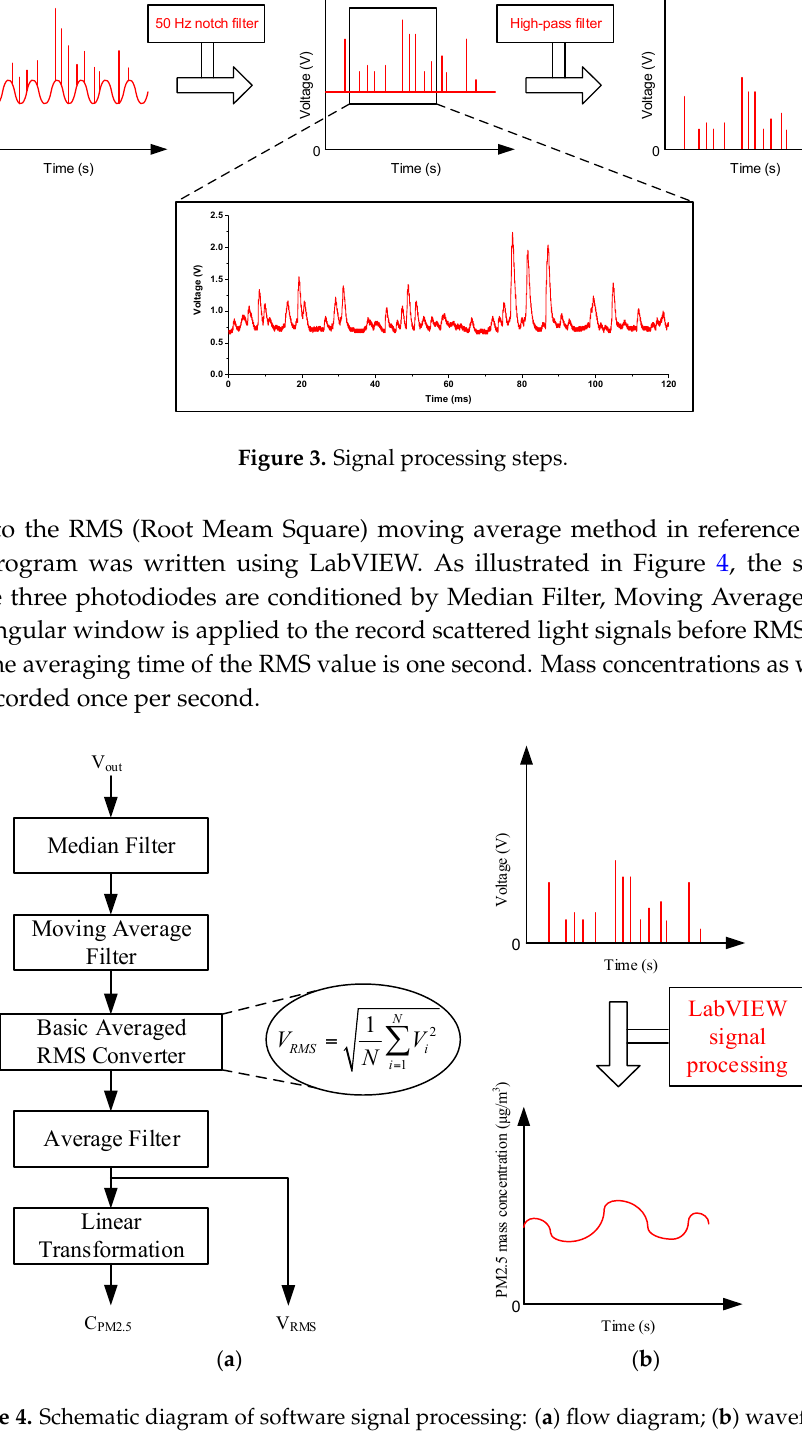
Figure 4. Schematic diagram of software signal processing: ( a ) flow diagram; ( b ) waveforms.